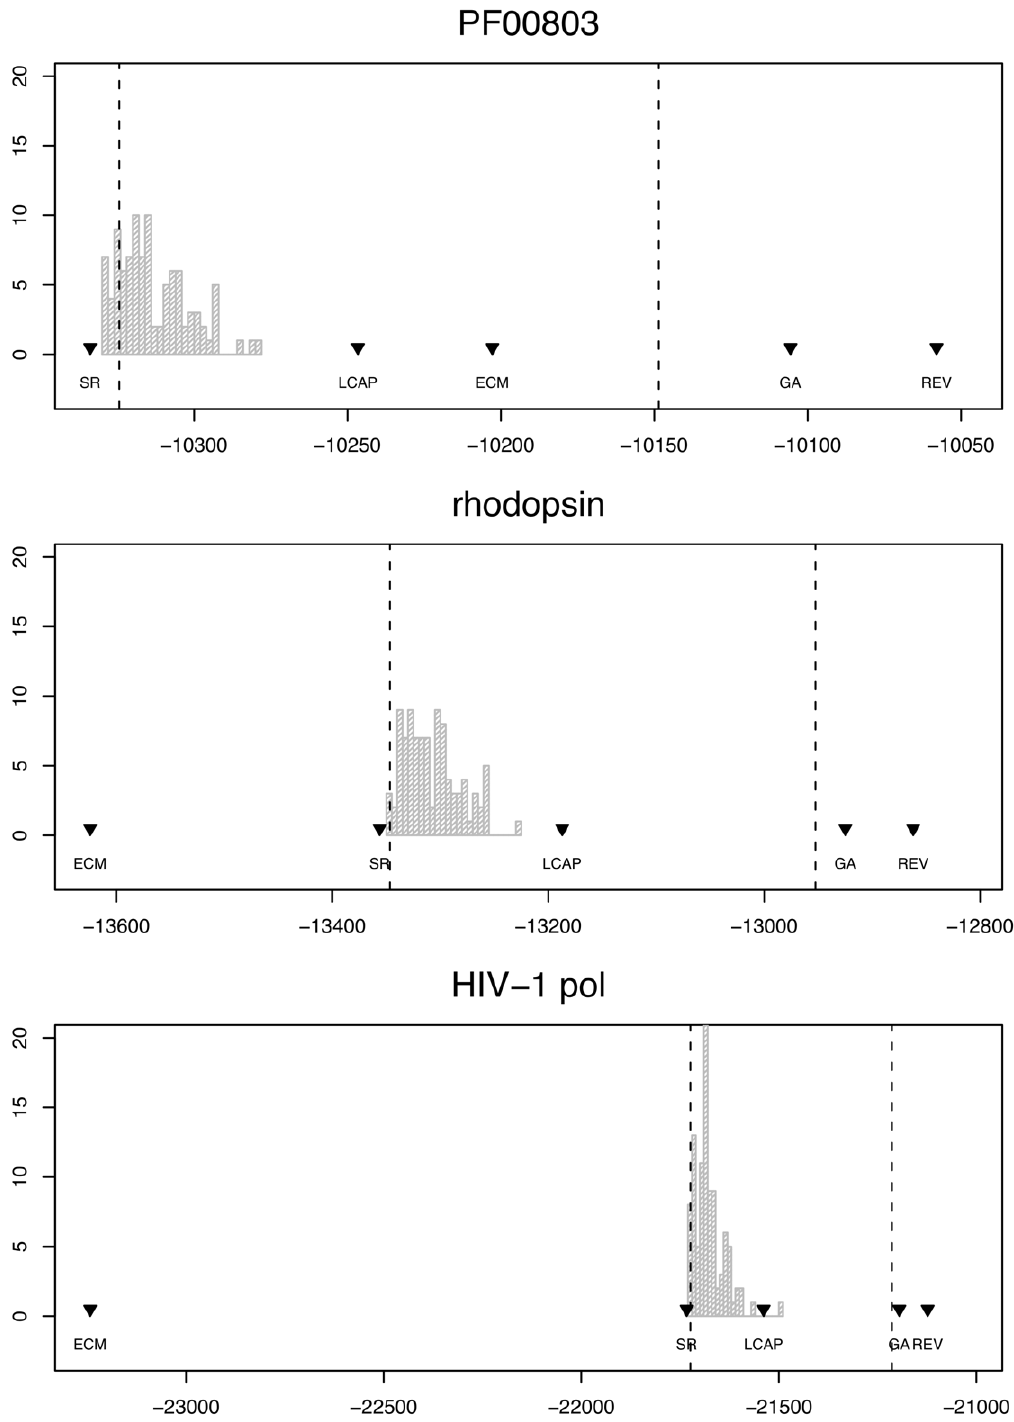
Figure 1.Distributionof loglikelihoodscores for 100 multi-rate models where amino-acid substitutionsare assigned randomly to 5 non- synonymous classes. The fitofsingle rate (SR), linear combinationof aminoacidproperties (LCAP),empirical codonmodel (ECM), Genetic Algorithm (GA) andthe general reversible model (REV) are shown as upside-down triangles. Number of rate classes inferred in theGAare3,4 and 5 for PF00803, rhodopsin andHIV-1 pol , respectively.Dashed lines indicate theloglikelihoodrequired to (i) reject thesingle rate model in favor of a 5 rate model (left), and (ii) reject a 5 rate model in favor of REV (right). All models were fitted using maximum likelihood estimates of position-specific nucleotide frequencies.